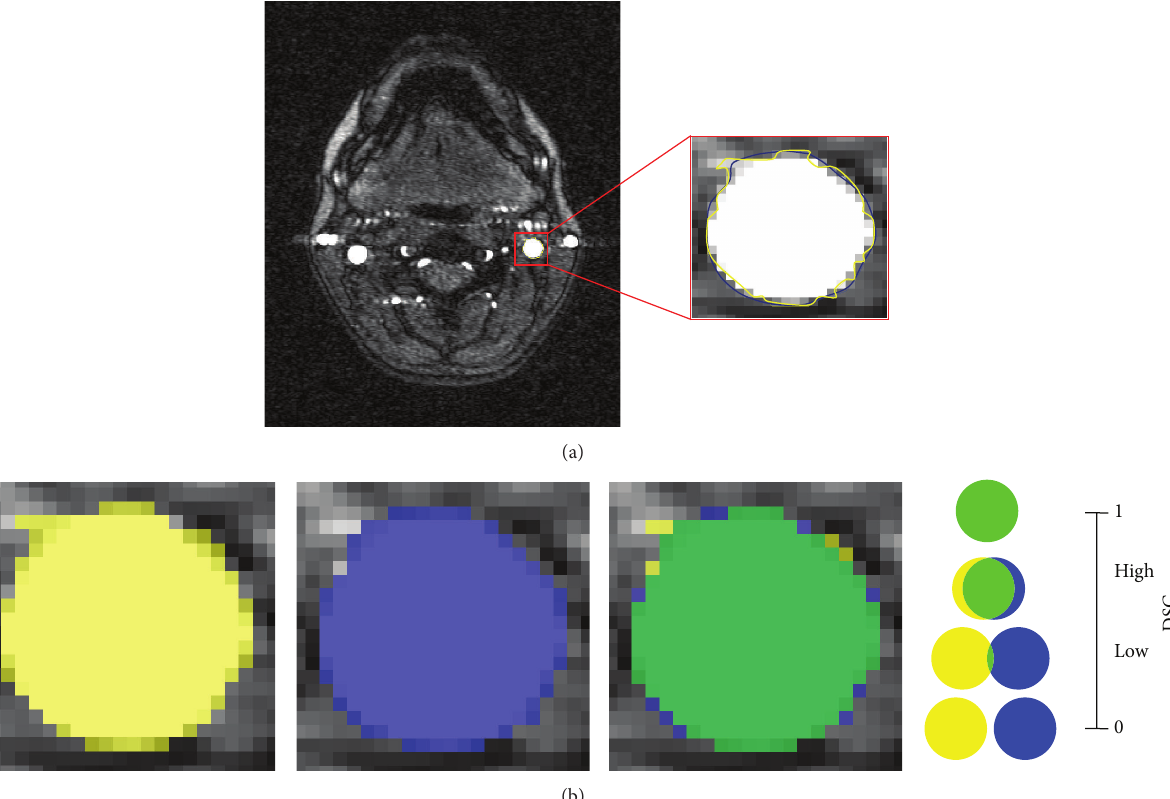
Figure 1: (a) shows the segmentation IJVl on a TOF MR image by two different operators (operator 1, yellow line; operator 2, blue line). (b) shows a graphical representation of Dice similarity coefficient (DSC): how it is computed and how it can be interpreted. Yellow area corresponds to the ROI identified by operator 1 (ROI1), blue area corresponds to the ROI identified by the operator 2 (ROI2), and green area is the overlapping region of the yellow and blue ROIs (ROI 1 ∩ ROI 2 ). The DSC is computed as 2 ∗ CSA ROI 1∩ ROI 2 /( CSA ROI 1 + CSA ROI 2 ). A schematic representation of different DSC values is reported on the right side of panel (b): from 0 (no overlap of the two areas) to 1 (perfect overlap of the two areas). Note that for equal cross-sectional areas, the other reliability indexes ( 𝜌 c and ICC) are perfect (equal to 1); instead, DSC can change, depending on the overlap of the two